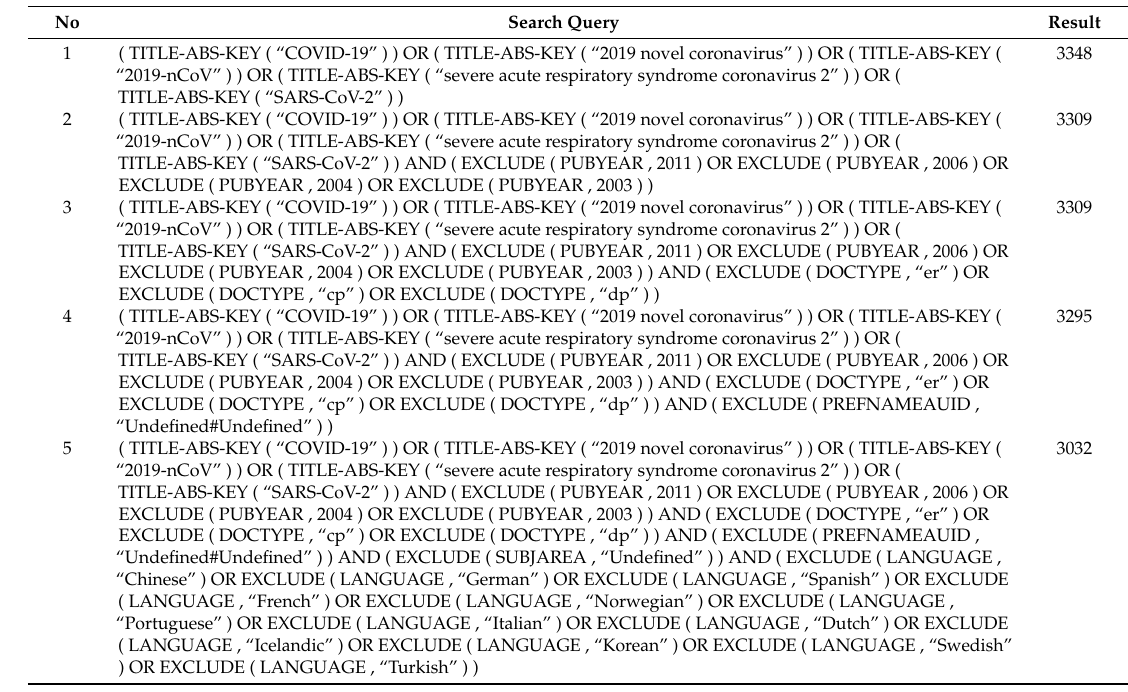
Table A3. Search query